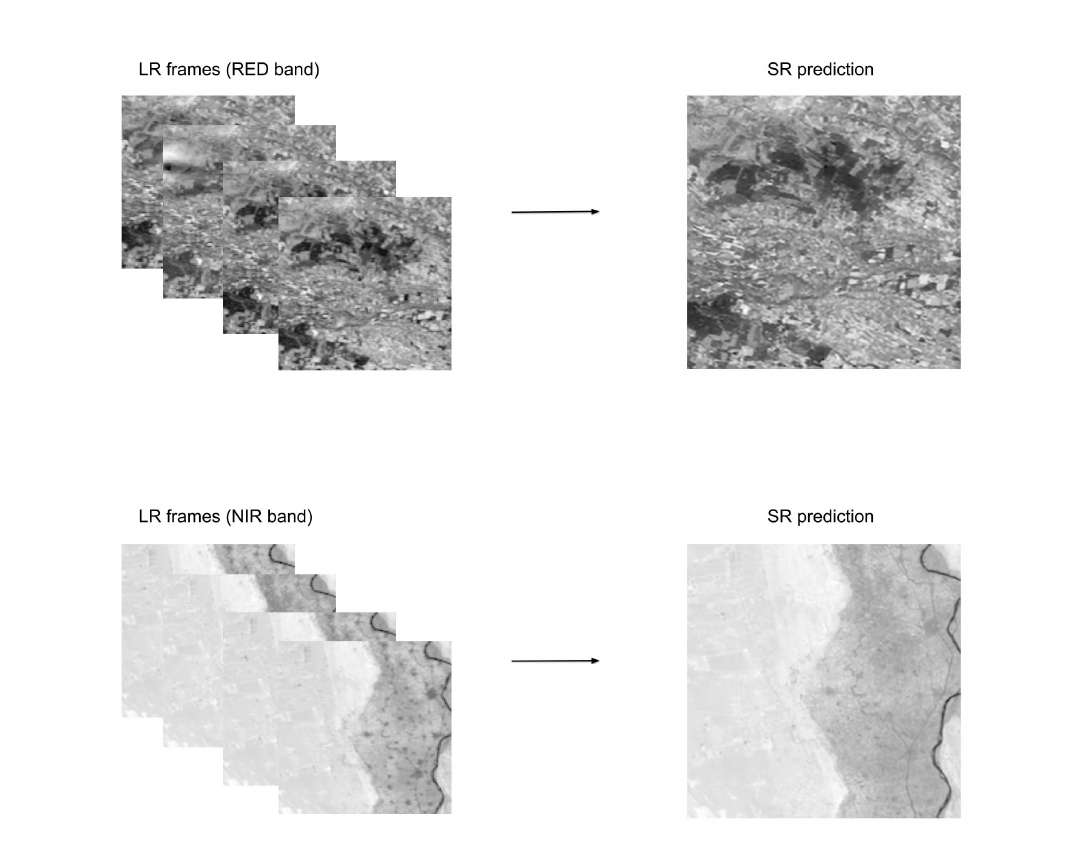
Figure 5. RED and NIR band SR example. The SR predicted images were obtained from our best 3DWDSRnet model (Table 1). The robustness of the method to artifacts can be seen in the example of the RED band, where the second frame (from left to right) shows clouds in the upper left that do not affect the SR